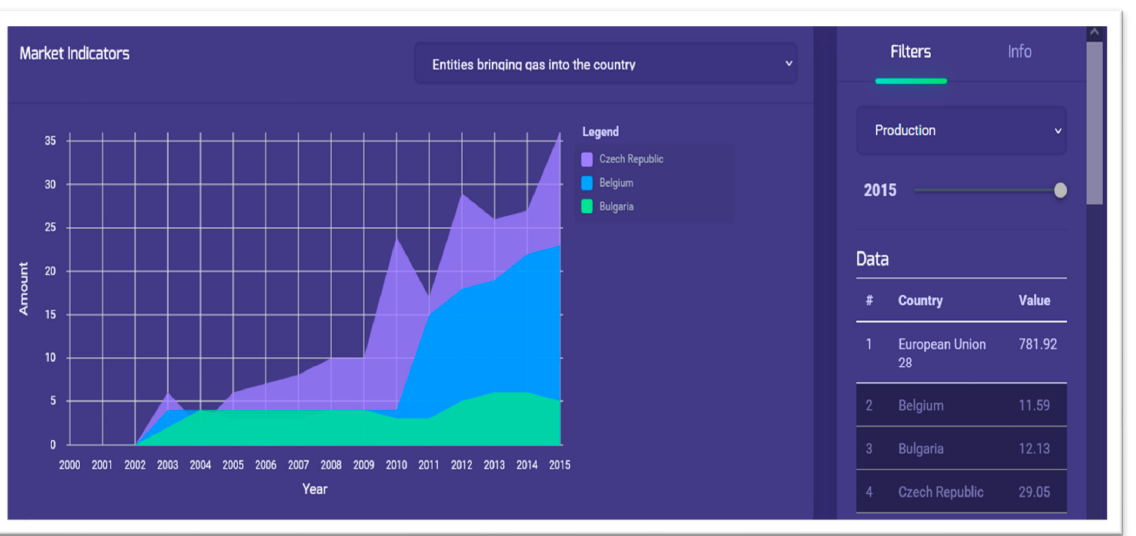
Figure 8. Final energy consumption by sector of an EU country. The area chart shows some market indicators related to natural gas and electricity. This chart shows how a market indicator of one or more EU countries changes over time (Figure 9).